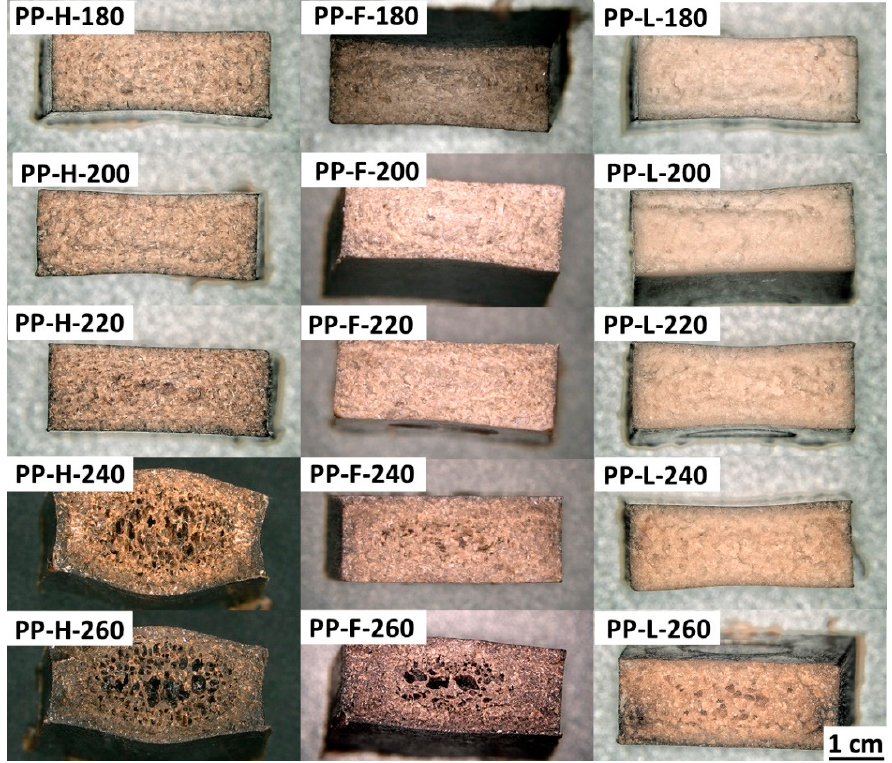
Figure 3. Micrographs of the fracture surfaces of composites processed at different temperatures.